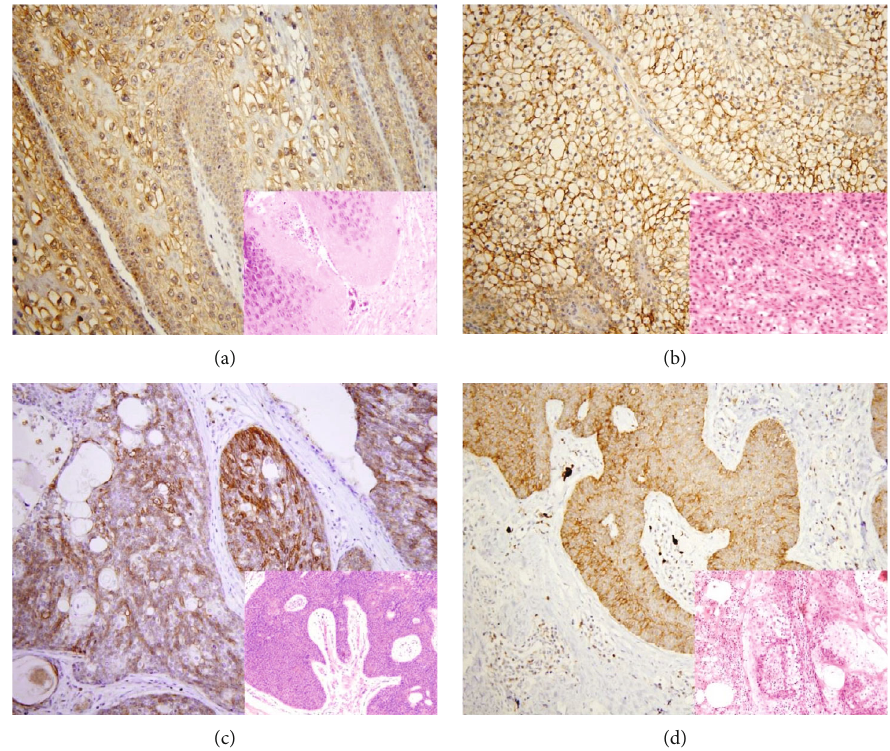
Figure 3: Expression of AQP3 in benign skin lesions and tumors. Distinctive AQP3 immunoreactivity is identi fi ed in molluscum contagiosum (a), hidradenoma (b), eccrine poroma (c), and sebaceoma (d) with corresponding fi gure of HE staining on the lower right- hand corner (magni fi cation: (a, b) 400x; (c, d)